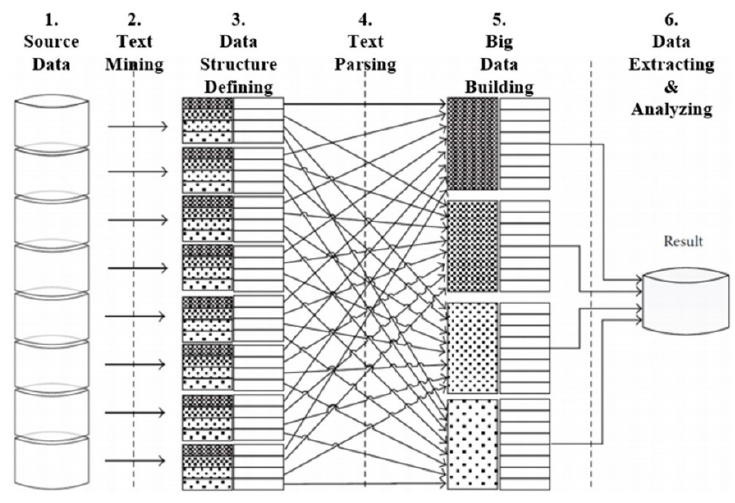
Figure 3. Big Data Building Steps for Cost and Schedule Data Integration.